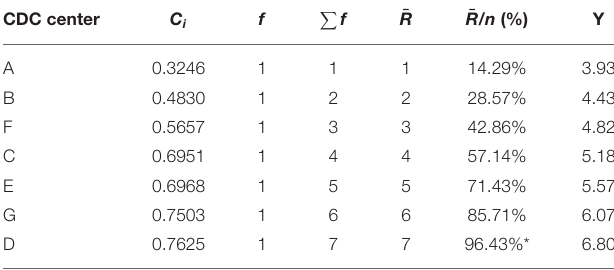
TABLE 6 | Comprehensive evaluation of RSR distribution for different C i values.